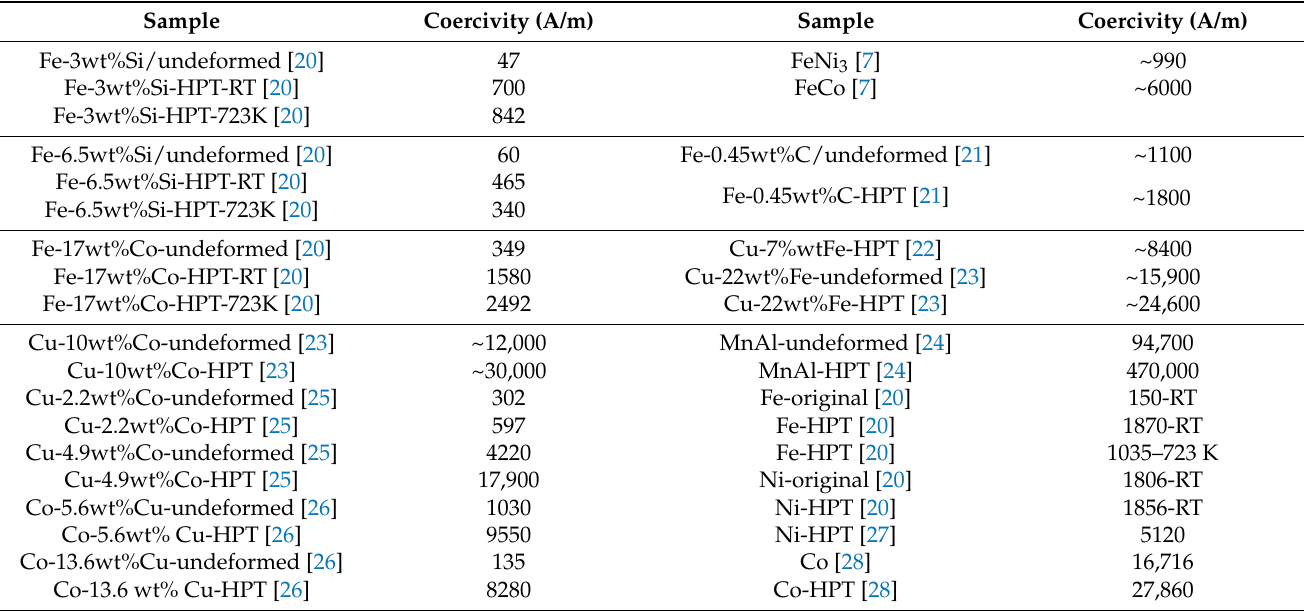
Table 1. The coercivity of the selected undeformed samples and HPT-deformed samples at room temperature (RT) or elevated